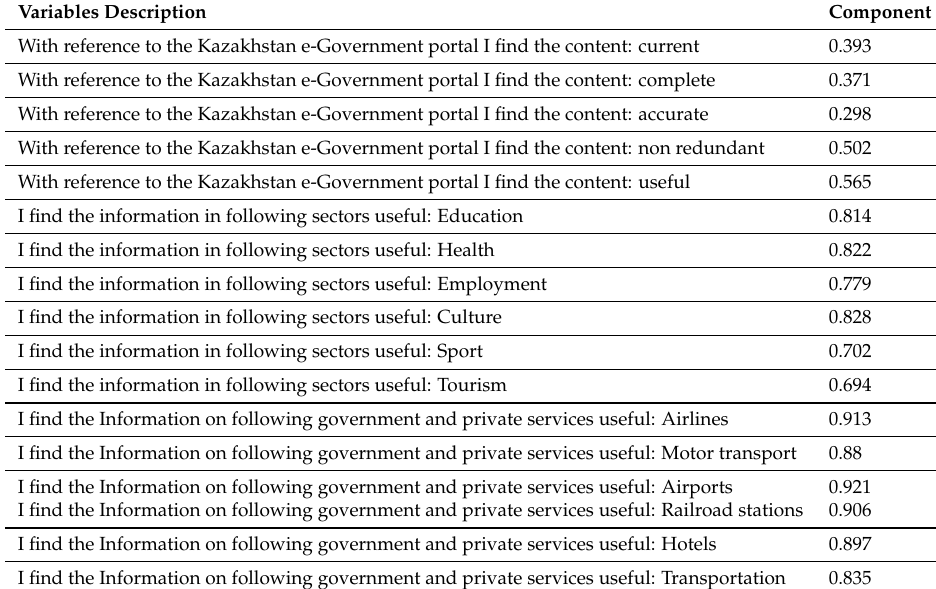
Table A5. Component matrix of PU